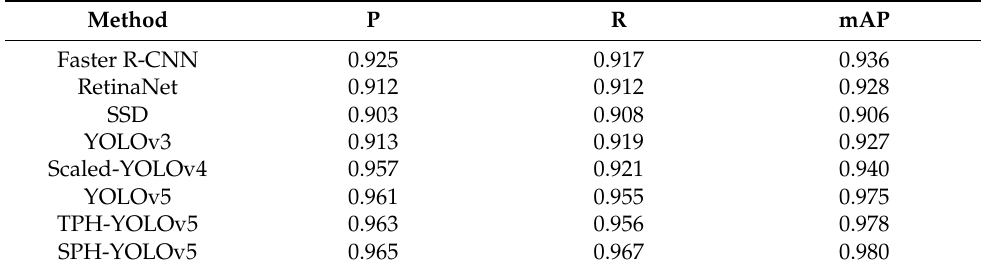
Table 2. Test results on the NWPU-VHR10 test dataset for different detection models.